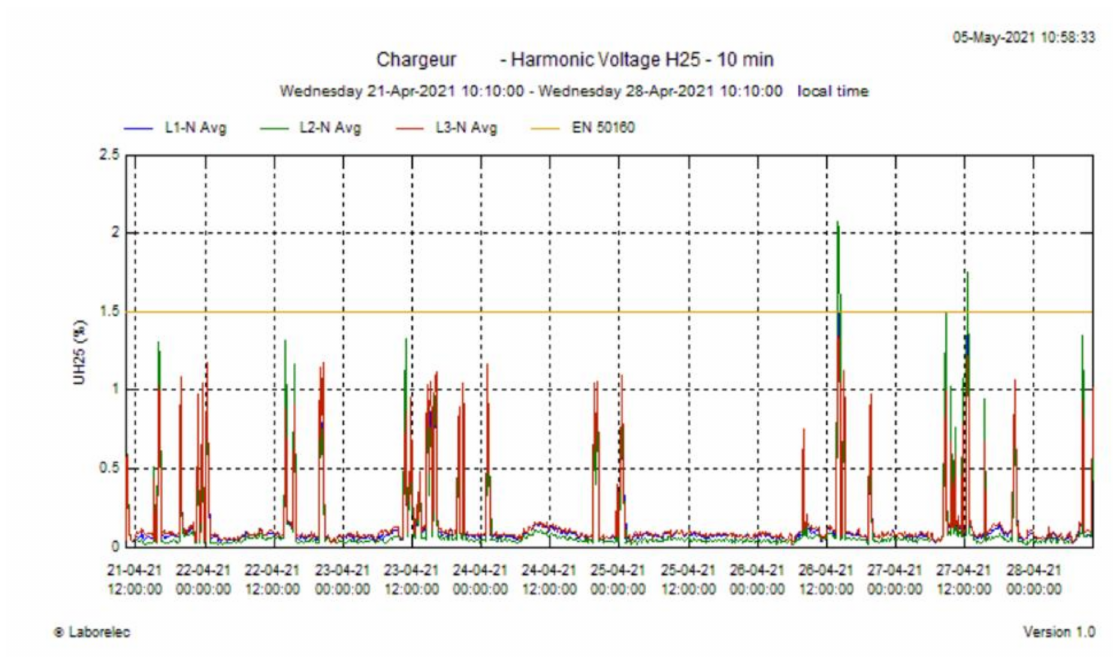
Figure 4. Harmonic voltage H25-10 min-1 week.